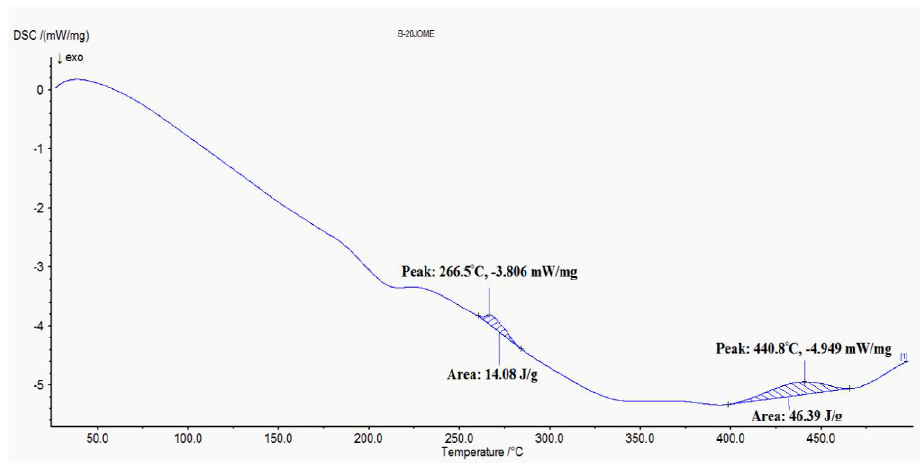
Table 4. Heat flow and enthalpy at peak temperature.